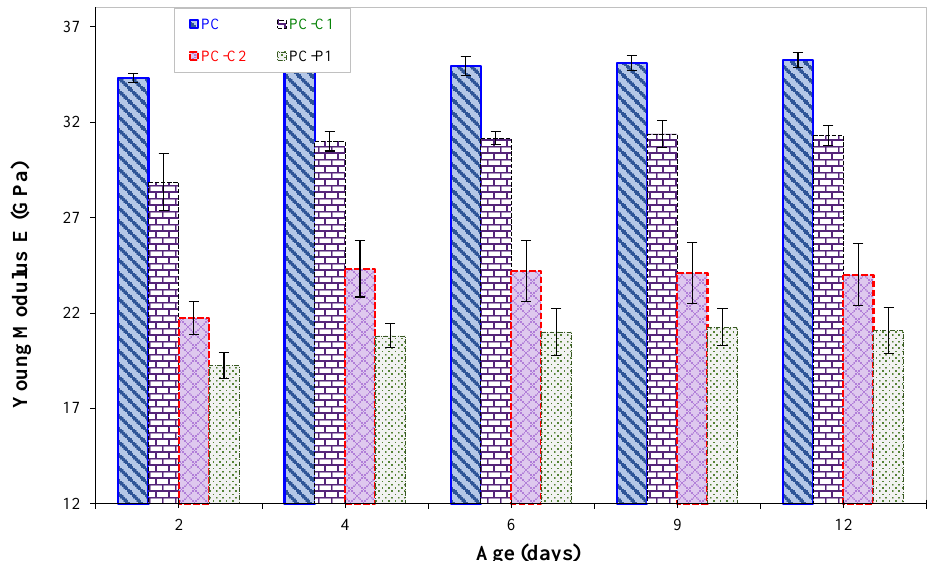
Figure 8. Elastic modulus vs. age for PC mixes.